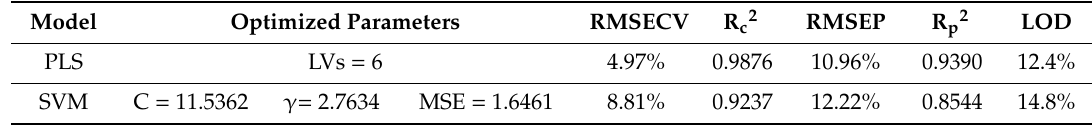
Table 2. Prediction results of gelatin adulteration by using the PLS model and SVM model, respectively. LOD: limit of detection.